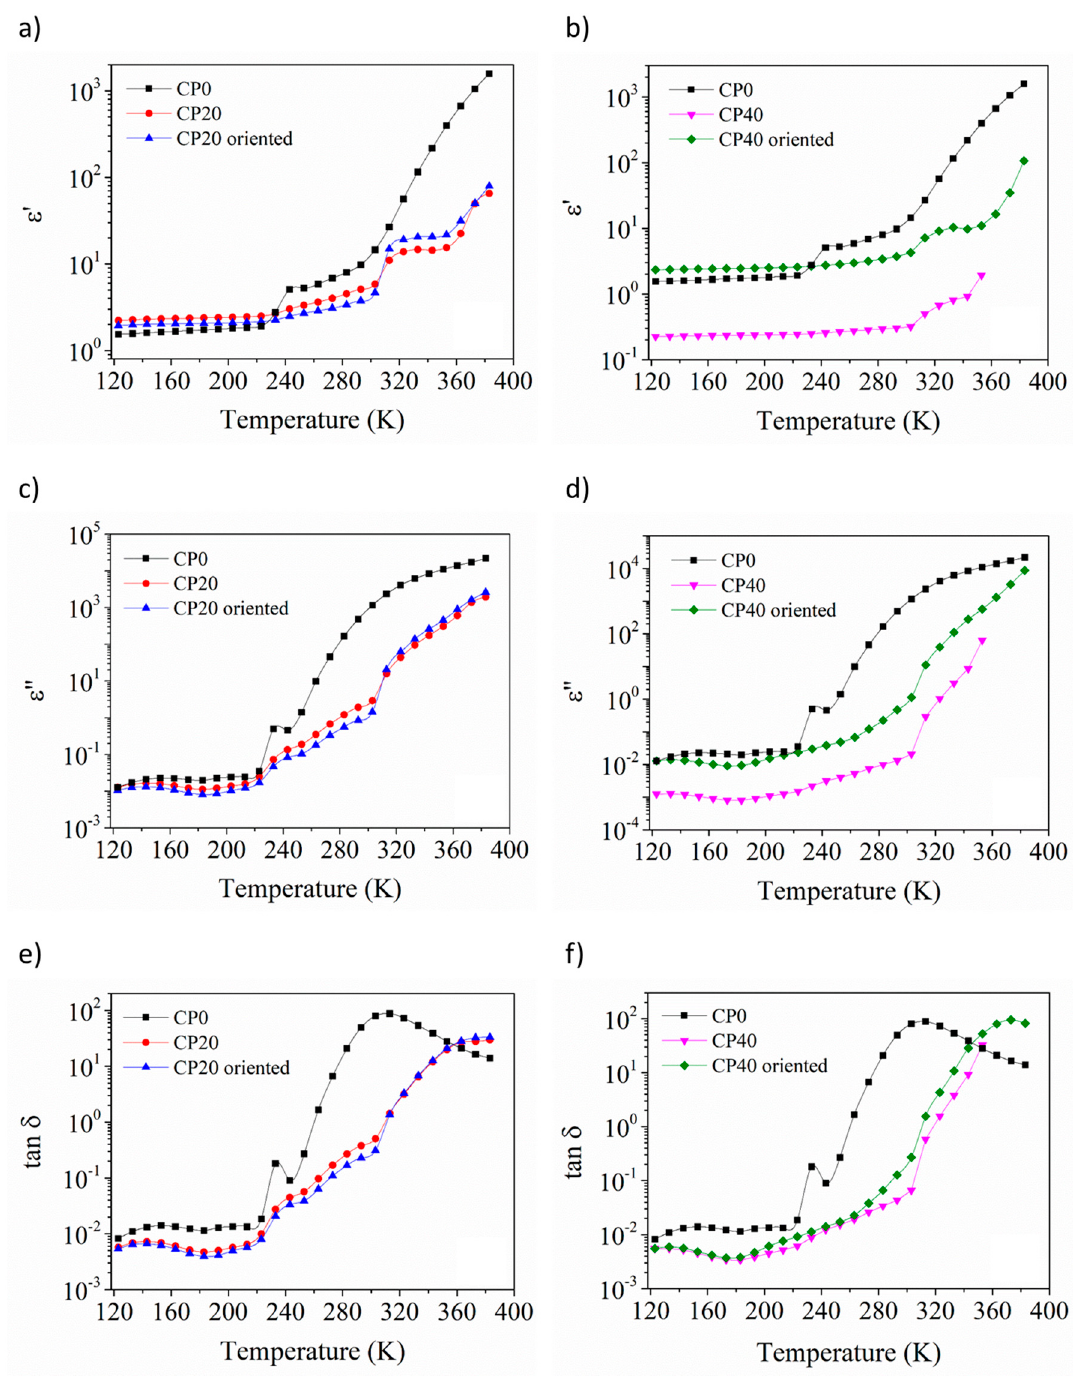
Figure 7. ( a , b ) Real part of the complex permittivity; ( c , d ) imaginary part of the complex permittivity; ( e , f ) loss tangent of the unmodified copolymer (CP0) of the modified oriented and unoriented copolymers CP20 and CP40, respectively, for a frequency of 10 Hz.